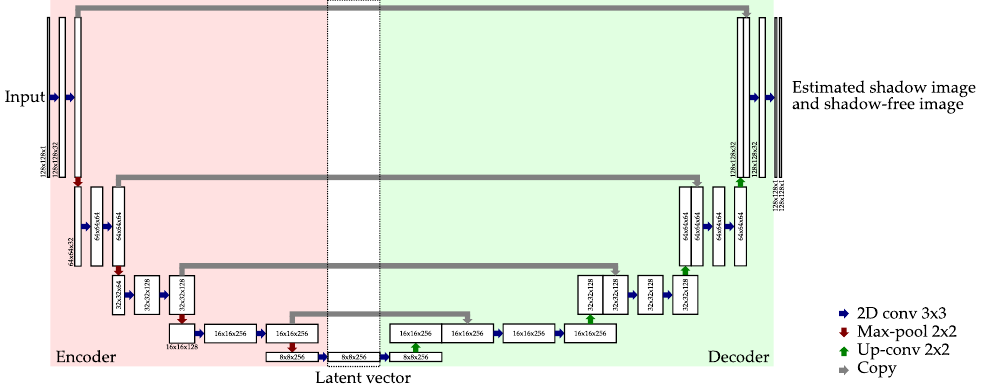
Figure A1. Detailed architecture of the encoder and the decoder for the proposed